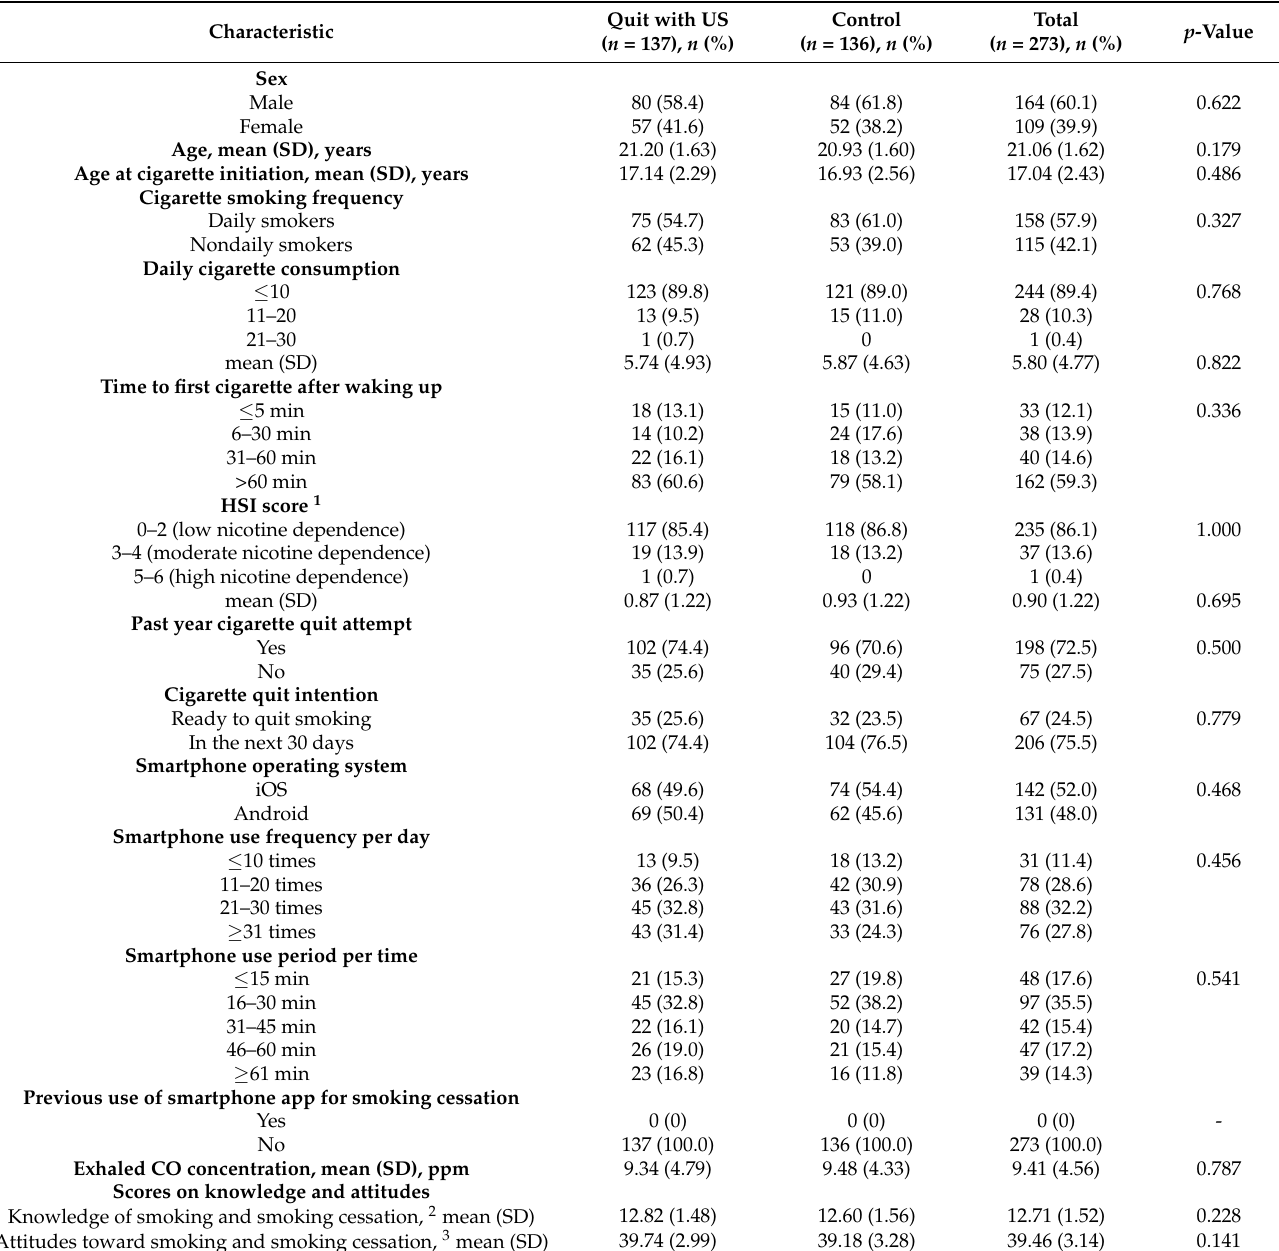
Table 1. Baseline characteristics of participants in the Quit with US